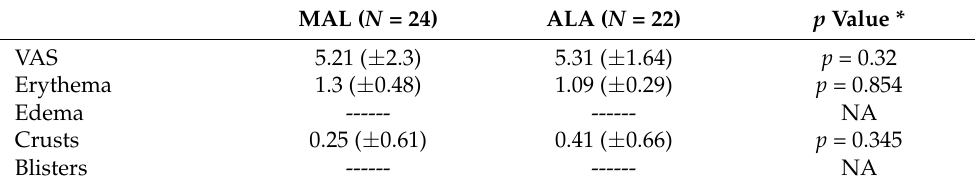
Table 3. Comparison of the pain in a visual analogue scale (VAS, 0–10)) and local side effects